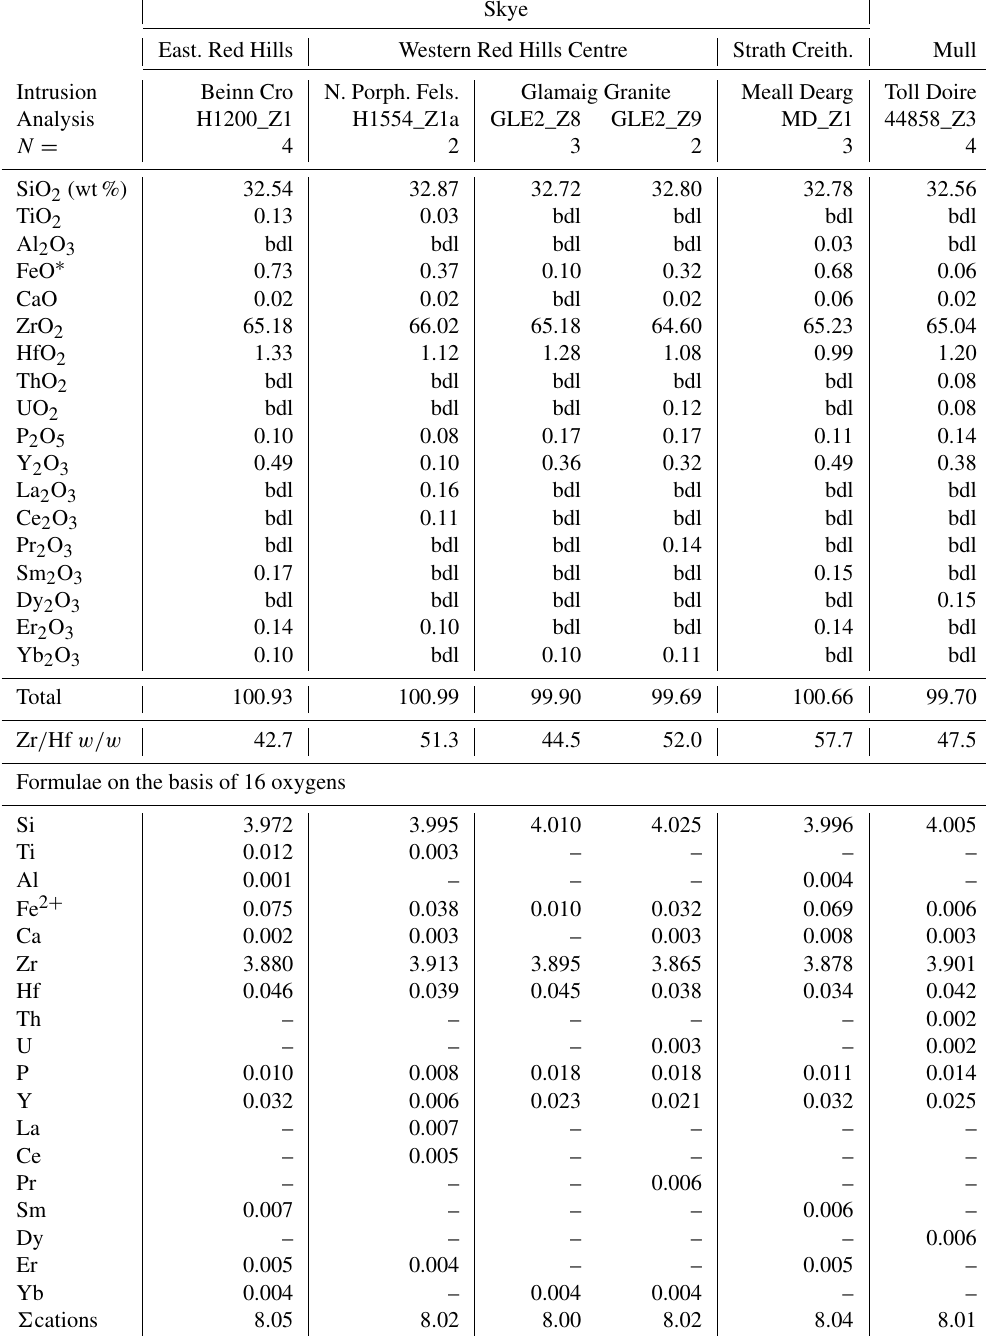
Table 5. Late-stage magmatic zircon compositions. Skye East. Red Hills Western Red Hills Centre Strath Creith. Mull Beinn Cro N. Porph. Fels. Glamaig